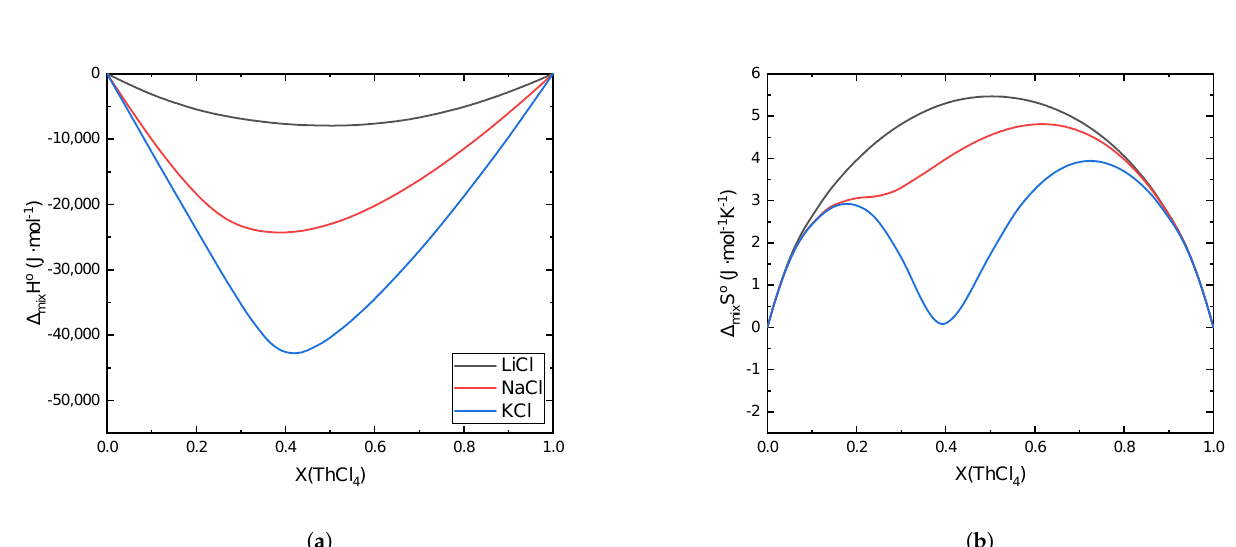
Figure 4. ( a ) Enthalpies and ( b ) entropies of mixing of the (A,Th)Cl x liquid solutions calculated at T = 1100 K.